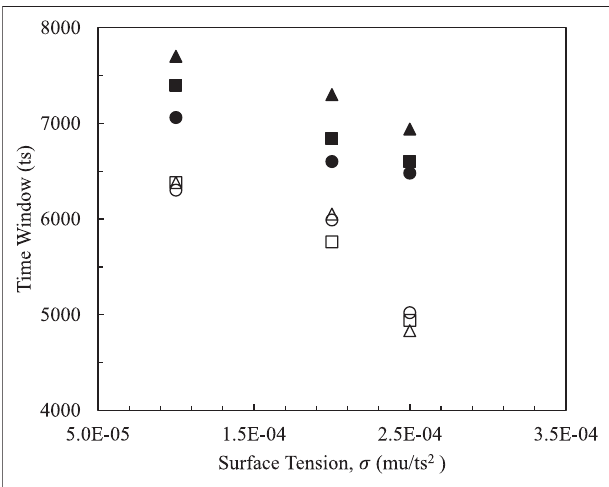
FIGURE4| Effectsofsurfacethicknessesontimewindowswith ρ p (cid:1) 10 and μ p (cid:1) 10: empty symbols stand for thicker surfaces ( d (cid:1) 10 lu) and solid symbols mean thin surfaces ( d (cid:1) 5 lu), respectively; squares ( R (cid:1) 35 lu), triangles ( R (cid:1) 25 lu), and circles ( R (cid:1) 15 lu) represent three speci fi ed droplet sizes, respectively.